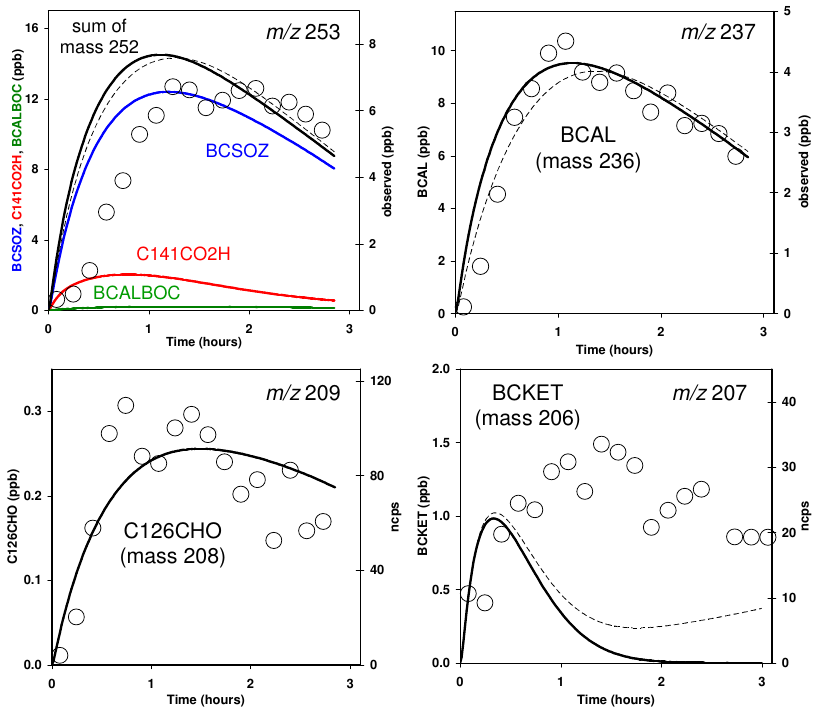
Fig. 15. Example time profiles simulated for selected first-generation oxygenated products (lines), compared with those for corresponding product ion signals measured using CIR-TOF-MS (points), during ACES photo-oxidation experiments. Measured signals for a given m / z incorporate the corresponding daughter ion signals identified in Table 3. Signals for the m / z 253 and m / z 237 families were calibrated as described in the text (see discussion of method and uncertainties in Sects. 3.2 and 6.3.1). Other signals are uncalibrated and presented as normalised counts per second (npcs). Comparisons are for experiments 03-07-08 ( m / z 253, 237 and 209) and 10-07-08 ( m / z 207). Broken lines in the m / z 253 and m / z 237 panels show the effect of including speculative formation of α -hydroxyhydroperoxides in the mechanism (see text). Broken line in m / z 207 panel is the results of a sensitivity test considering potential interfering signals (see text).